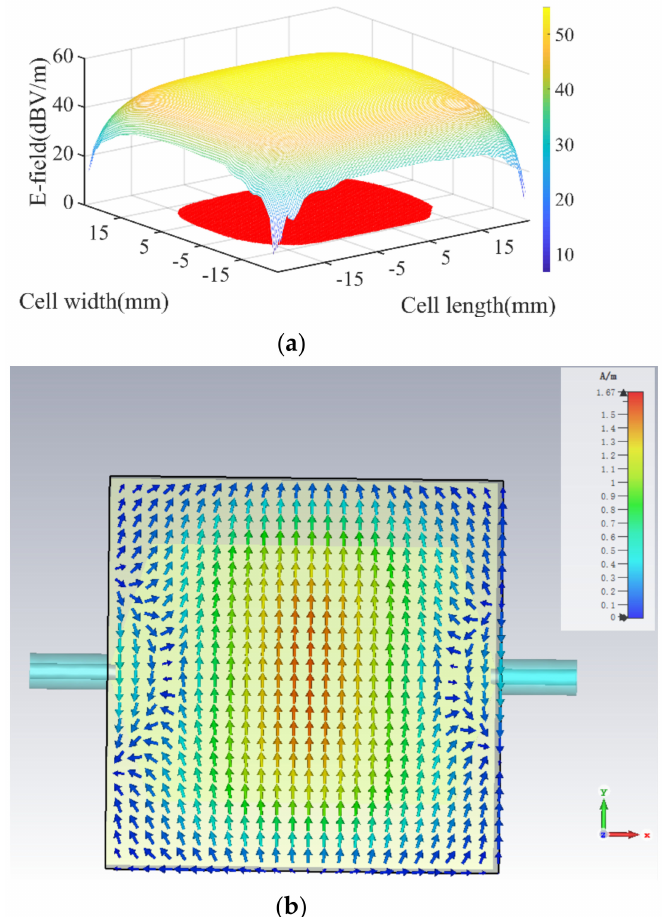
Figure 5. Field distribution at the top area of the traditional IC-Stripline cell. ( a ) The electric field distribution (the red shaded area is the horizontal projection of the 3 dB uniform field region). ( b ) The magnetic field